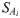
Prediction of context-dependent regions by the FuzPred method.(A) Prediction of binding mode profiles. Comparable probabilities for disorder-to-order transition (pDO, dark gray) and disorder-to-disorder transition (pDD, light gray) indicate a disordered binding mode for the region of residues 45–55 (grey box), which involves both the docking and the KIS motif, consistently with the experimental data [33] (top panel). Based on the binding profile, this region can fluctuate between ordered and disordered interactions (bottom panel), which will depend on the signaling pathway. The SAi values indicate that both the docking motifs and the N-terminal part of the KIS domain are capable to establish different binding modes, consistent with their involvement in disordered interactions. Selected MKK4 conformers docked onto p38α structure (PDB:1lew). The docking motif (marine) and the KIS domain (light blue) are shown (coordinates as a courtesy of Dr. Malene Ringkjobing-Jensen). (B) Prediction of phosphorylation-induced folding. Trans-autophosphorylation induces folding of the activation loop in the dual-activity enzyme Ire1, which promotes its oligomerisation [19]. Packing of four monomers (wheat, light blue, pale green and light pink surfaces) (PDB: 3fbv) are stabilised by the ordered activation loop (cartoon, the phosphorylated Ser841 is shown by spheres). FuzPred predicts slightly higher probabilities for disorder-to-order transition (pDO, dark gray, top panel) for the activation loop (grey box) than for disorder-to-disorder transition (pDD, light gray, top panel), indicating that it can fold upon binding. The high SAi values (bottom panel) corroborate that the activation loop can sample both disordered and ordered states in the bound form, which could be shifted towards the folded form by phosphorylation.